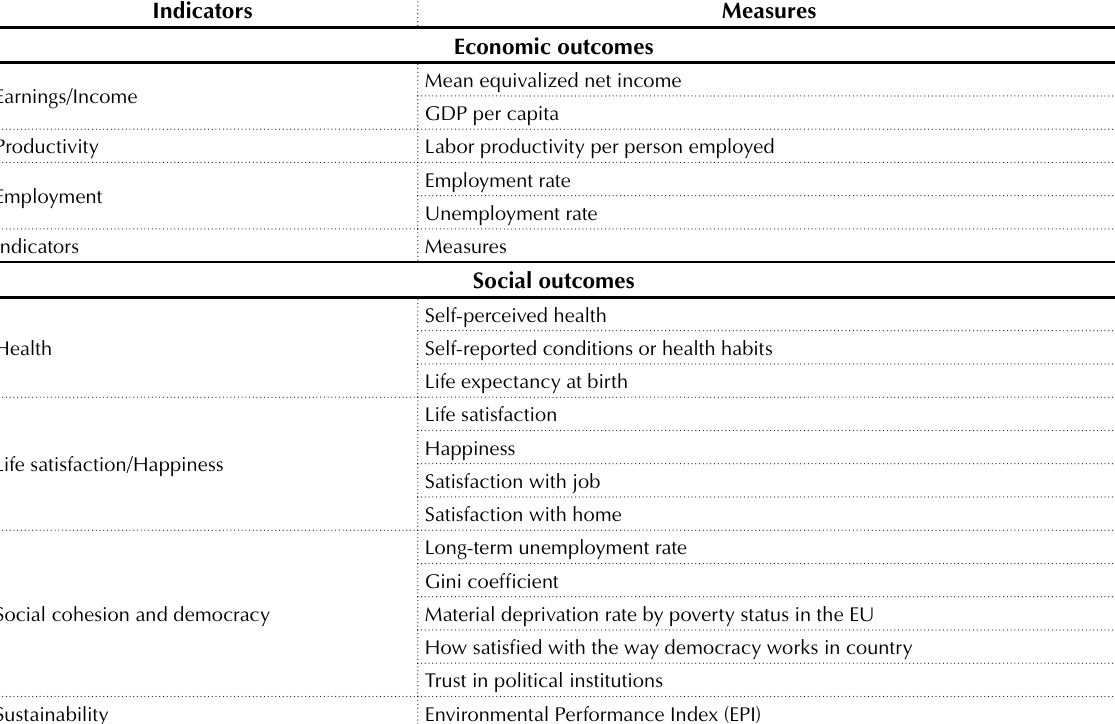
Table 7. Economic and social outcomes of learning in context of Ukrainian Lifelong Learning